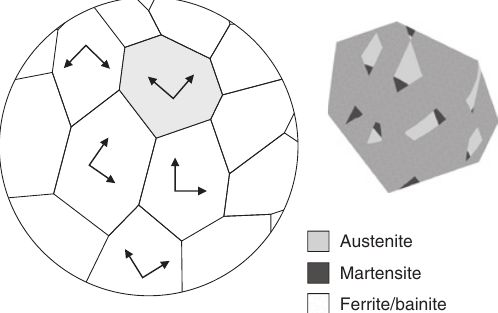
Figure 1. Thus the phase transformation takes place